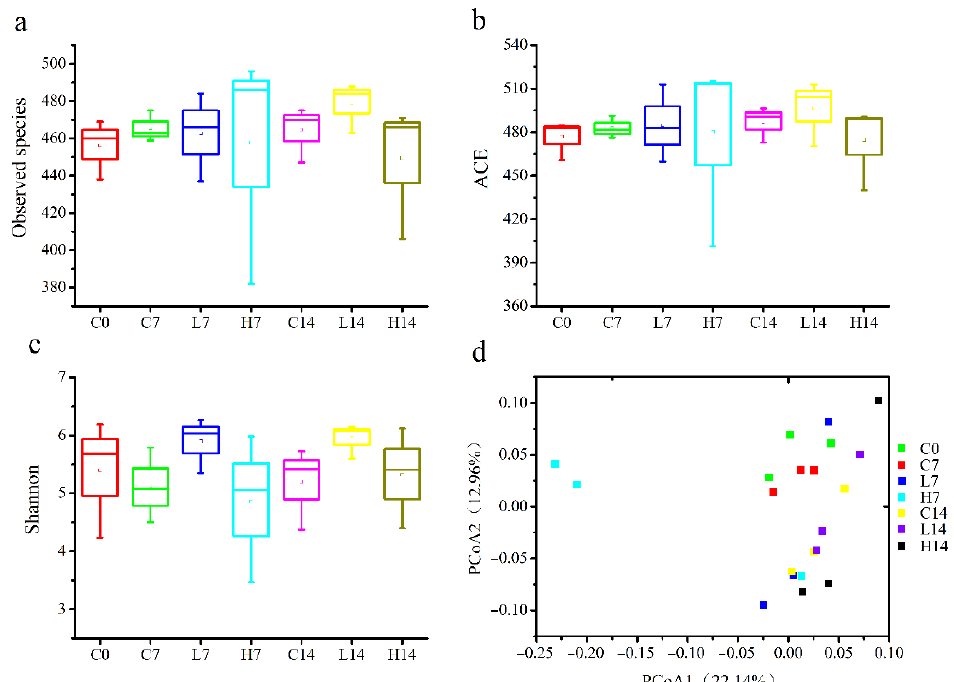
Figure 2. Alpha and beta diversity of the gut microbiota in mice during administration of PS. ( a ) Observed species, ( b ) ACE estimate of richness, ( c ) Shannon estimate of richness values, and ( d ) PCoA (the linear distance in ( d ) between the two samples represents the difference in microbiota.). C0 indicates the samples from groups C, L, and H at day 0; C7 and C14 indicate the samples from the group C at days 7 and 14, respectively; L7 and L14 indicate the samples from group L at days 7 and 14, respectively; and H7 and H14 indicate the samples from group H at days 7 and 14, respectively. The overall structural changes between groups were analyzed by PCoA (Figure